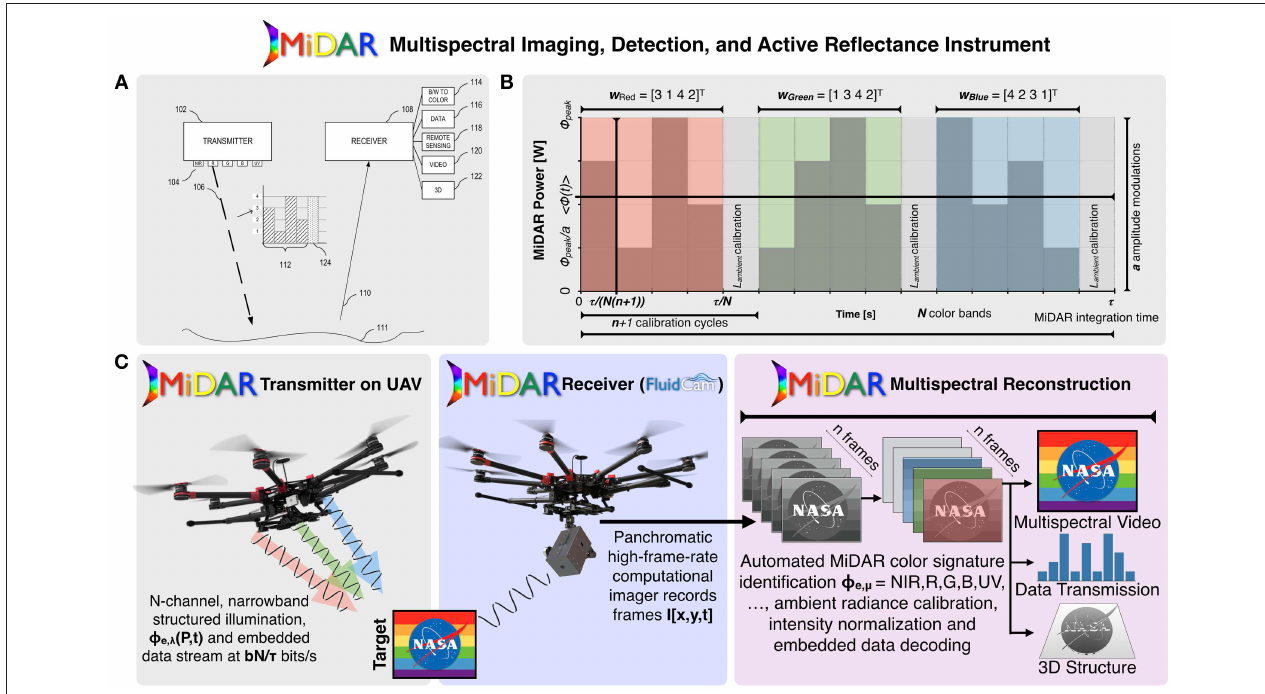
FIGURE 8 | MiDAR, the NASA Multispectral, Imaging, Detection, and Active Reflectance Instrument. (A) MiDAR is an active multispectral/hyperspectral instrument that uses multiple narrowband optical emitters to illuminate a target with structured light (MiDAR Transmitter). The reflected light is captured by a telescope and high-frame-rate panchromatic focal plane array (MiDAR Receiver) with a high-performance onboard heterogenous computing stack, which creates hyperspectral images at video framerates, and decodes embedded optical communications in real-time (Chirayath, 2018a). (B) The structured illumination pattern generated by the MiDAR transmitter allows for simultaneous optical communication and calibrated measurement of a target’s reflectance at multiple wavelengths, independent of ambient illumination conditions. (C) MiDAR can be operated in a bistatic or monostatic configuration. For remote sensing applications, MiDAR has been tested on